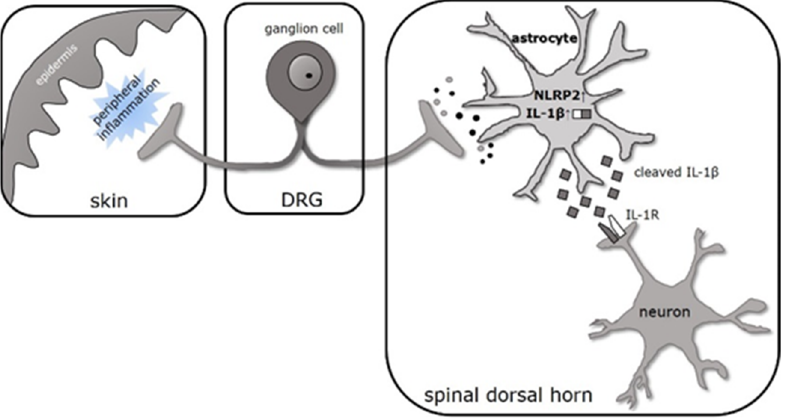
Figure 8. Proposed role of inflammasome activation in increased neuronal excitability during CFA- evoked persistent pain in spinal dorsal horn. CFA treatment induces peripheral inflammation in skin. Inflammatory mediators secreted by the local cells sensitize the nociceptive nerve fiber termi- nals and, in turn, the primary afferent fibers, terminating in the superficial laminae of the spinal dorsal horn release substances which activate astrocytes. When mechanical pain sensitivity is highest, the NLRP2 inflammasome sensor and IL-1 β is overexpressed in astrocytes. Our previous find- ings suggest that the major target of the secreted, cleaved IL-1 β is spinal neurons. IL-1R1 ligand binding affects neuronal excitability via interacting NMDA and AMPA receptor-mediated gluta- mate signaling, which can lead to activation of the local neuronal networks and the nociceptive sensory pathways.